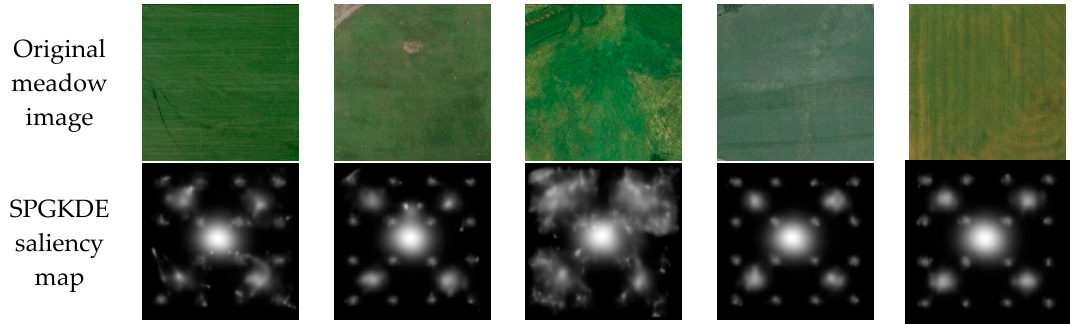
Figure 10. Meadow category images and corresponding saliency maps.